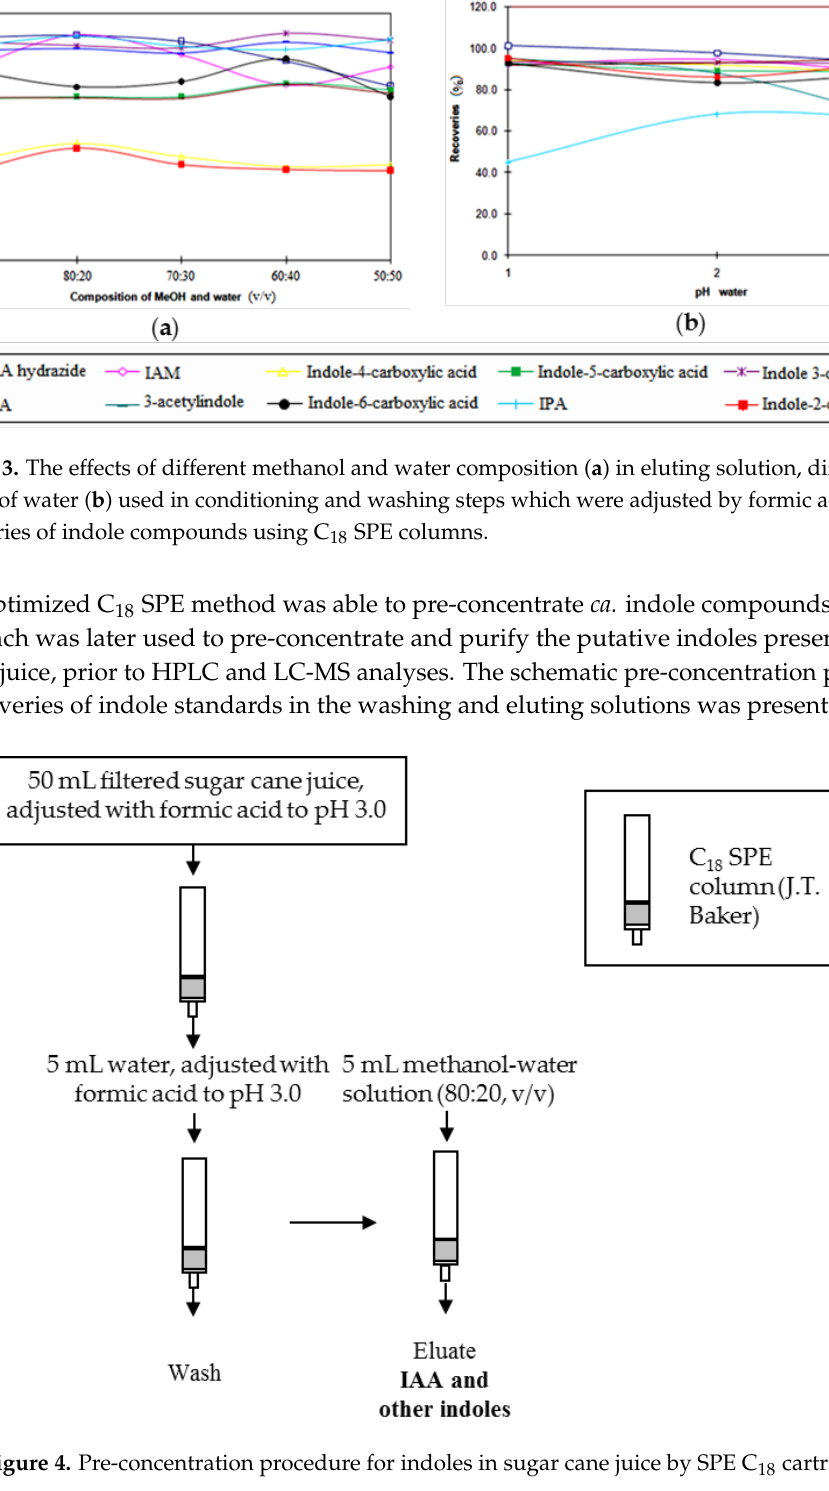
Figure 4. Pre-concentration procedure for indoles in sugar cane juice by SPE C 18 cartridge.